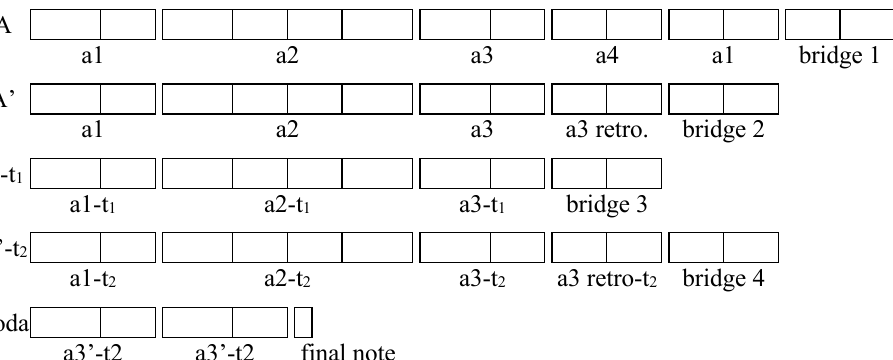
Figure 4. Musical structure of the excerpt from the xylophone part of ‘Porgy and Bess’, by G. Gershwin. Each rectangle represents one beat (four sixteenth notes); identical letters and indexes (e.g. a1) denote the repetition of the same musical material; ‘bridge’ indicates a musical section that leads to the following section with different musical material; ‘retro’ means ‘retrograde’ and indicates an inver- sion of the original pattern; ‘t’ denotes a transposition of the musical material, i.e. a translation of the musical pattern a few bars to the left or to the right on the keyboard of the xylophone; a3’ is a variation on a3, mainly a reorganization of the 3 sub-patterns that constitute this